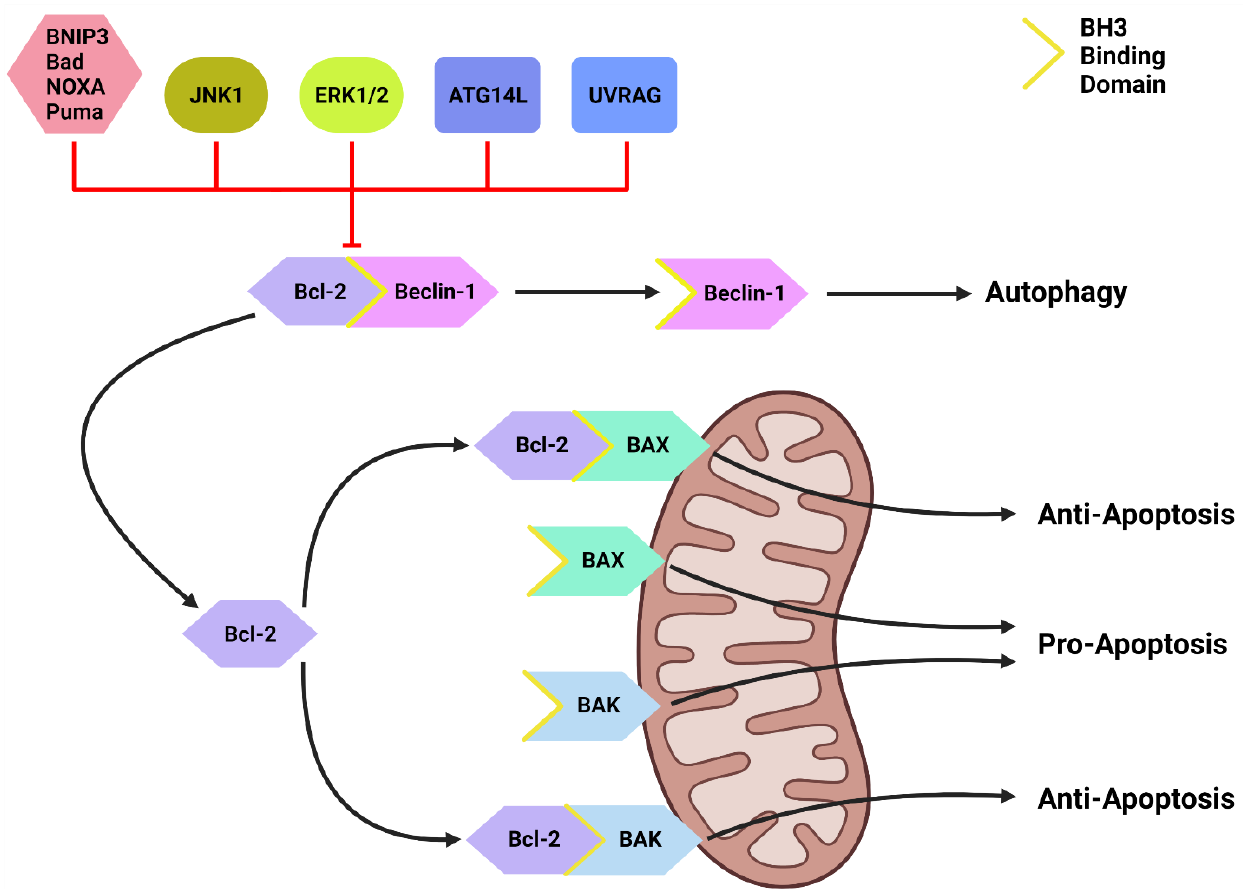
Figure 2. The Bcl-2/Beclin-1 Interaction. Bcl-2 family proteins (BNIP3, Bad, NOXA, Puma) that compete for the BH3 binding site and other proteins such as JNK1, ATG14L and UVRAG can disrupt the Bcl-2/Beclin-1 complex. This disruption frees Beclin-1 to form the PI3KC-C1 and initiate autophagic initiation or PI3KC-C2 to promote autolysosome fusion. Free Bcl-2 can also bind to the BH3-binding site on BAX and BAK to protect the mitochondria and suppress apoptotic function. Created with BioRender.com (accessed on 4 March 2022).